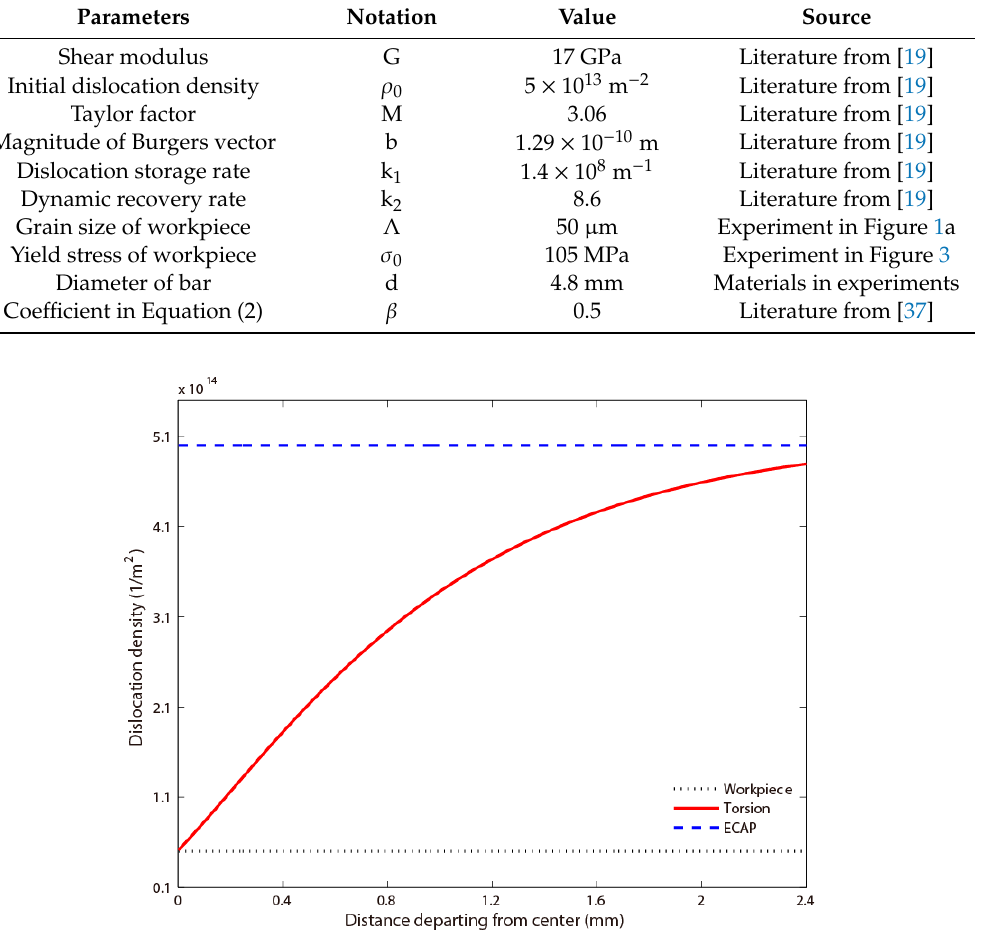
Figure 9. Dislocation density distribution along radius direction for AZ31B processed by different deformation modes.